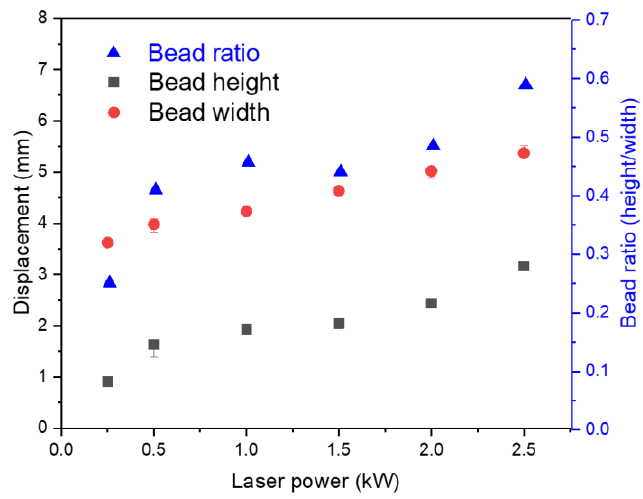
Figure 6. Bead height, width, and aspect ratio with various laser power.